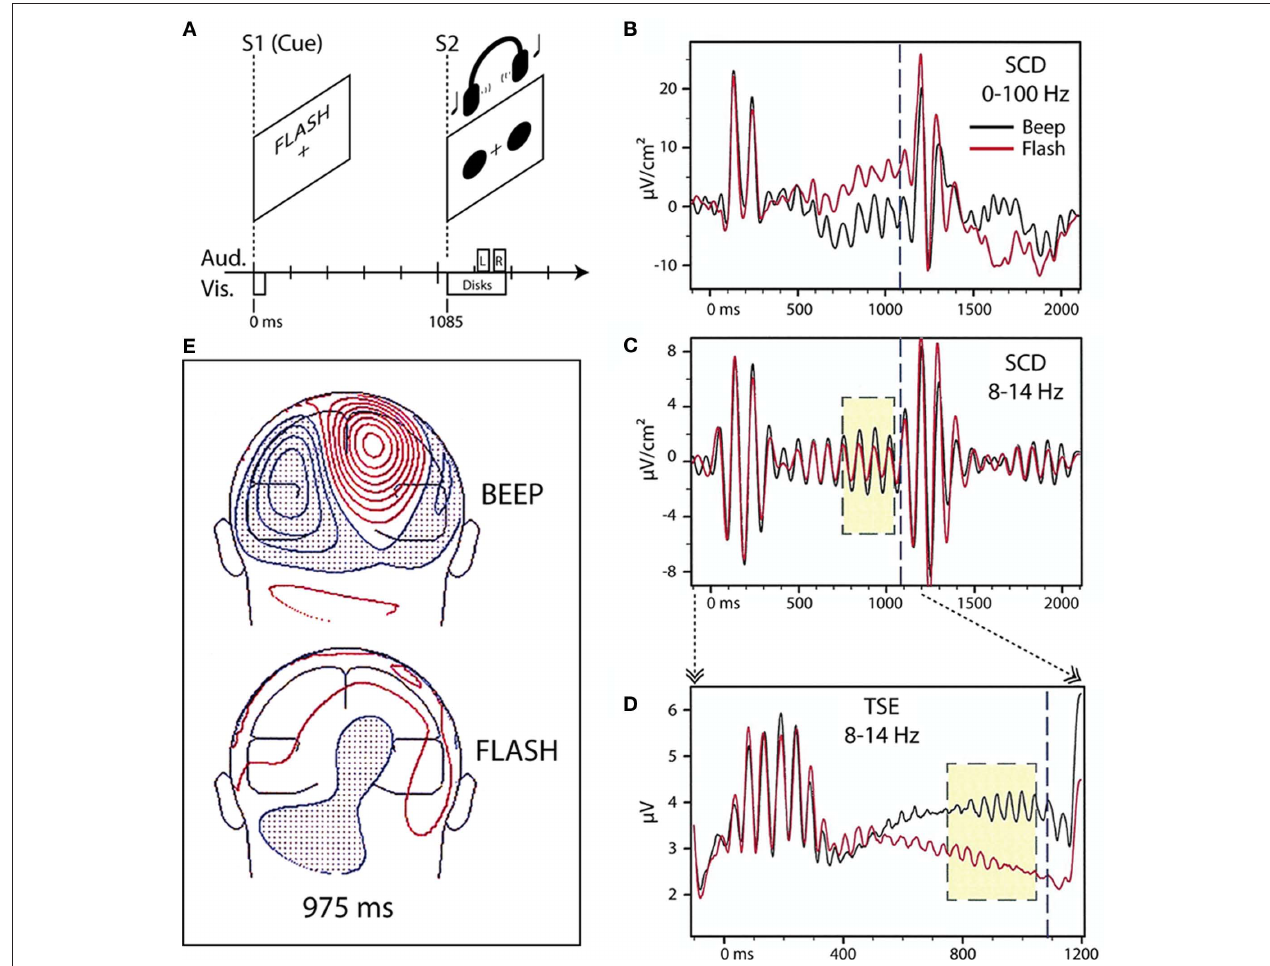
one subject (BH) at a right parieto-occipital scalp site to the beep (black trace) and flash (red trace) cues. (C) The same waveforms, band-pass filtered (8–14 Hz) reveal greater stimulus-locked alpha activity in the 300-ms (yellow box) before onset of the compound S2 (1085 ms, dashed blue line) when attention has been cued to the auditory modality. (D) Temporal–spectral evolution (TSE) waveforms for the alpha band, derived for the cue-target interval by full-wave rectifying the individual band-pass filtered trials prior to averaging, show a difference in the total alpha amplitude (i.e., both stimulus-locked and non-stimulus-locked). (E) Posterior view of the topographical distribution of current-density 975 ms following presentation of beep (top) and flash (bottom) cues for one subject (KH). Greater parietal field power is evident for the auditory cue compared to the visual cue. Red iso-contour lines (0.1 μV/cm 2 increments) indicate positive values and